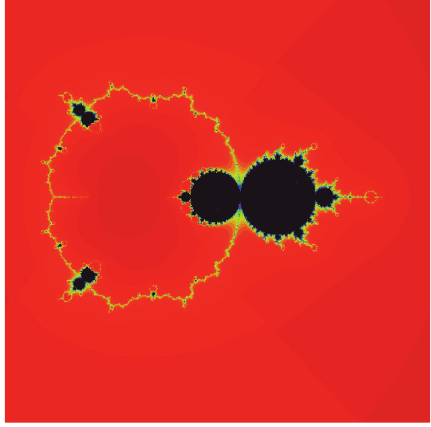
Figure 1: Parameter